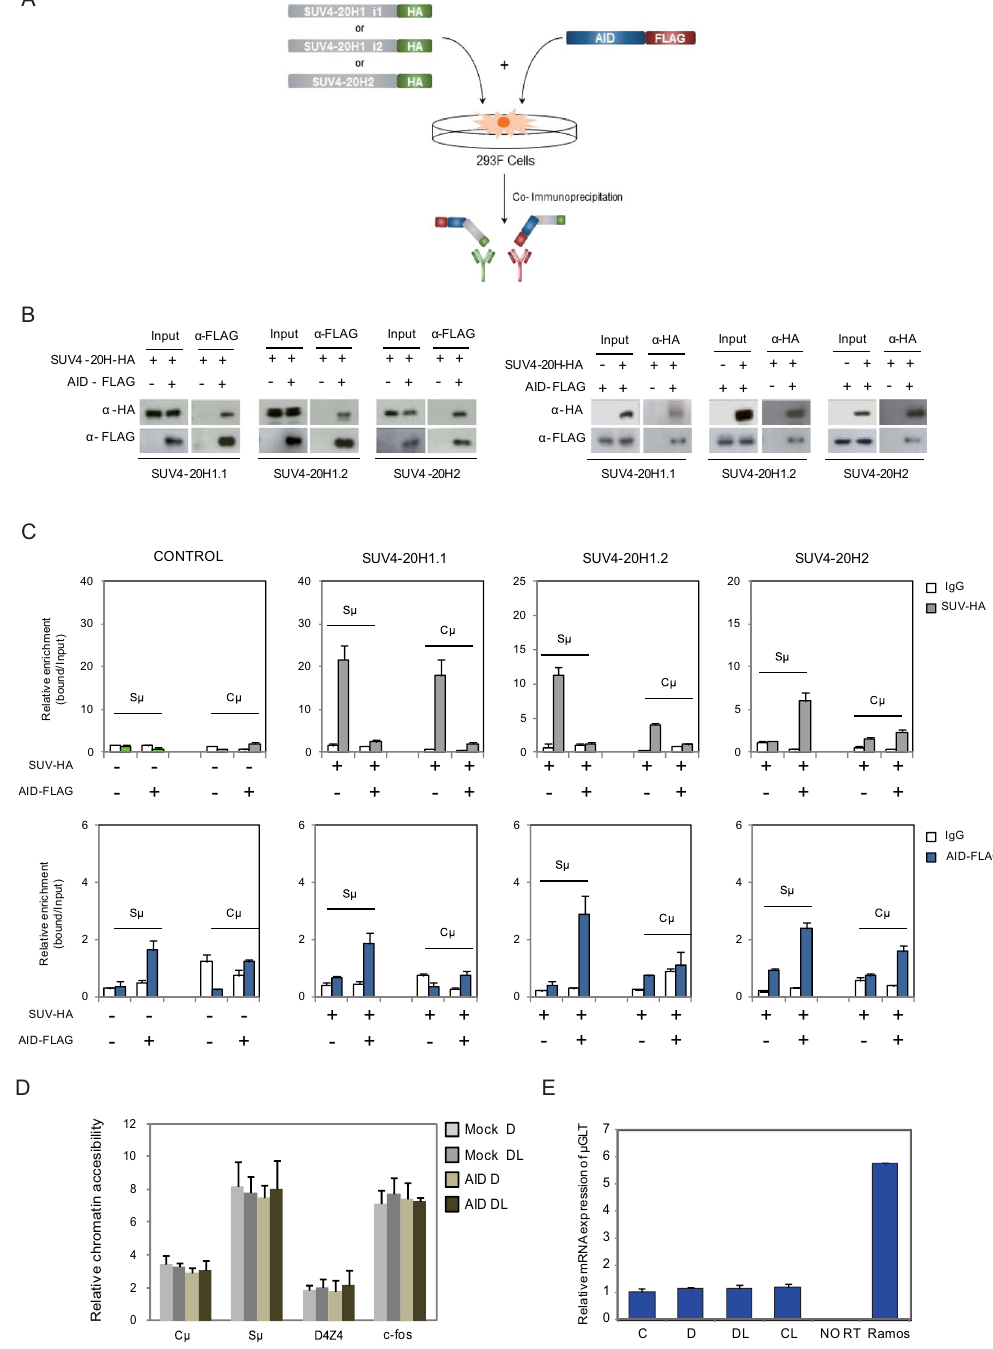
Figure 3. AID interacts with SUV4-20H enzymes and recruits them to IgH S μ regions ( A ) Scheme depicting immunoprecipitation experiments of 293F cells co-transfected with Flag-tagged AID and each of the HA- tagged SUV4-20H enzymes: SUV4-20H1.1, SUV4-20H1.2 and SUV4-20H2. AID was also transfected on its own. Material immunoprecipitated with anti-HA was then blotted and visualised with anti-FLAG to determine its potential interaction with AID. The reciprocal experiment was also performed, using anti-FLAG to immunoprecipitate AID and anti-HA was used to test the interaction with each of the SUV4-20H enzymes. ( B ) Western blot assays showing the results of the above experiment ( C ) ChIP assays showing the recruitment of AID and SUV4-20H enzymes at the C μ and S μ regions. 293F cells were co-transfected or not with AID-FLAG construct plus the different SUV4-20H-HA enzymes constructs. After 24 hours, cells were fixed, lysed and chromatin sonicated to perform ChIP assays with control IgG, anti-FLAG antibody to immunoprecipitate AID or anti-HA antibody to pull down SUV4-20H enzymes. The upper section shows the association of SUV4-20H enzymes with the S μ and C μ regions. Light gray bars indicate the relative enrichment of SUV4-20H enzymes (HA antibody) with respect to input fraction. White bars represent negative control of enrichment (IgG).